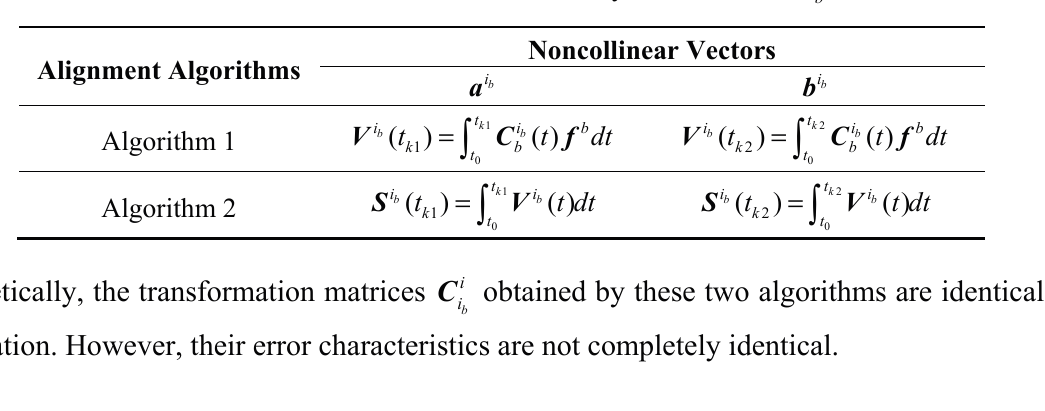
Table 2. Noncollinear vectors in body inertial frame